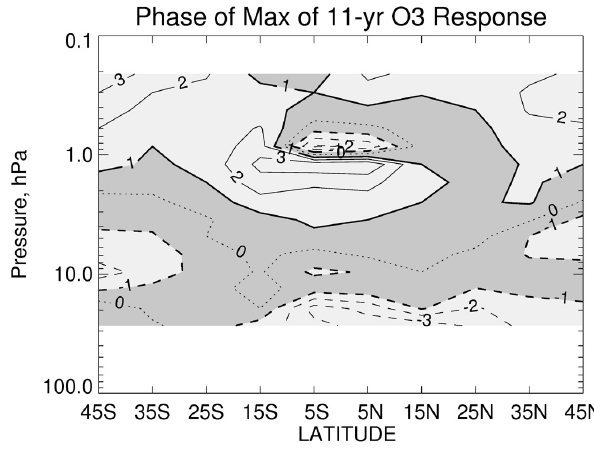
Fig. 13. As in Fig. 7, but for the phase of the 11-yr terms from the HALOE ozone.